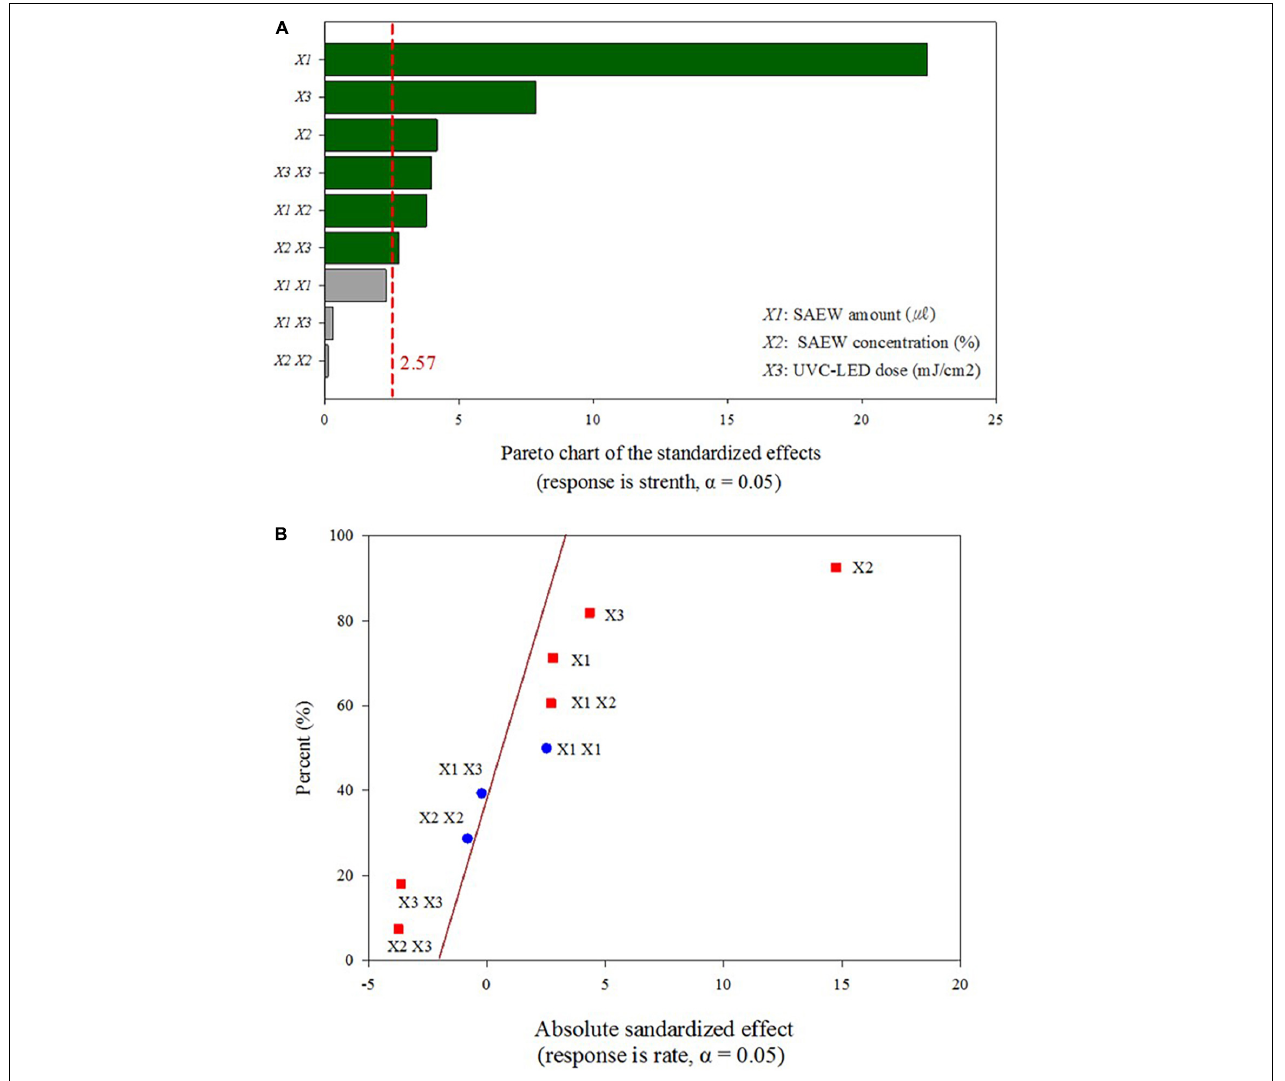
FIGURE 3 | Pareto chart of standardized effects for the response values of the combination of the sprayed slightly acidic electrolyzed water (SAEW) treatment and ultraviolet C light-emitting diode (UVC-LED) irradiation at optimized disinfection conditions. (A) Pareto chart of standardized effects, (B) normal plots for standardized